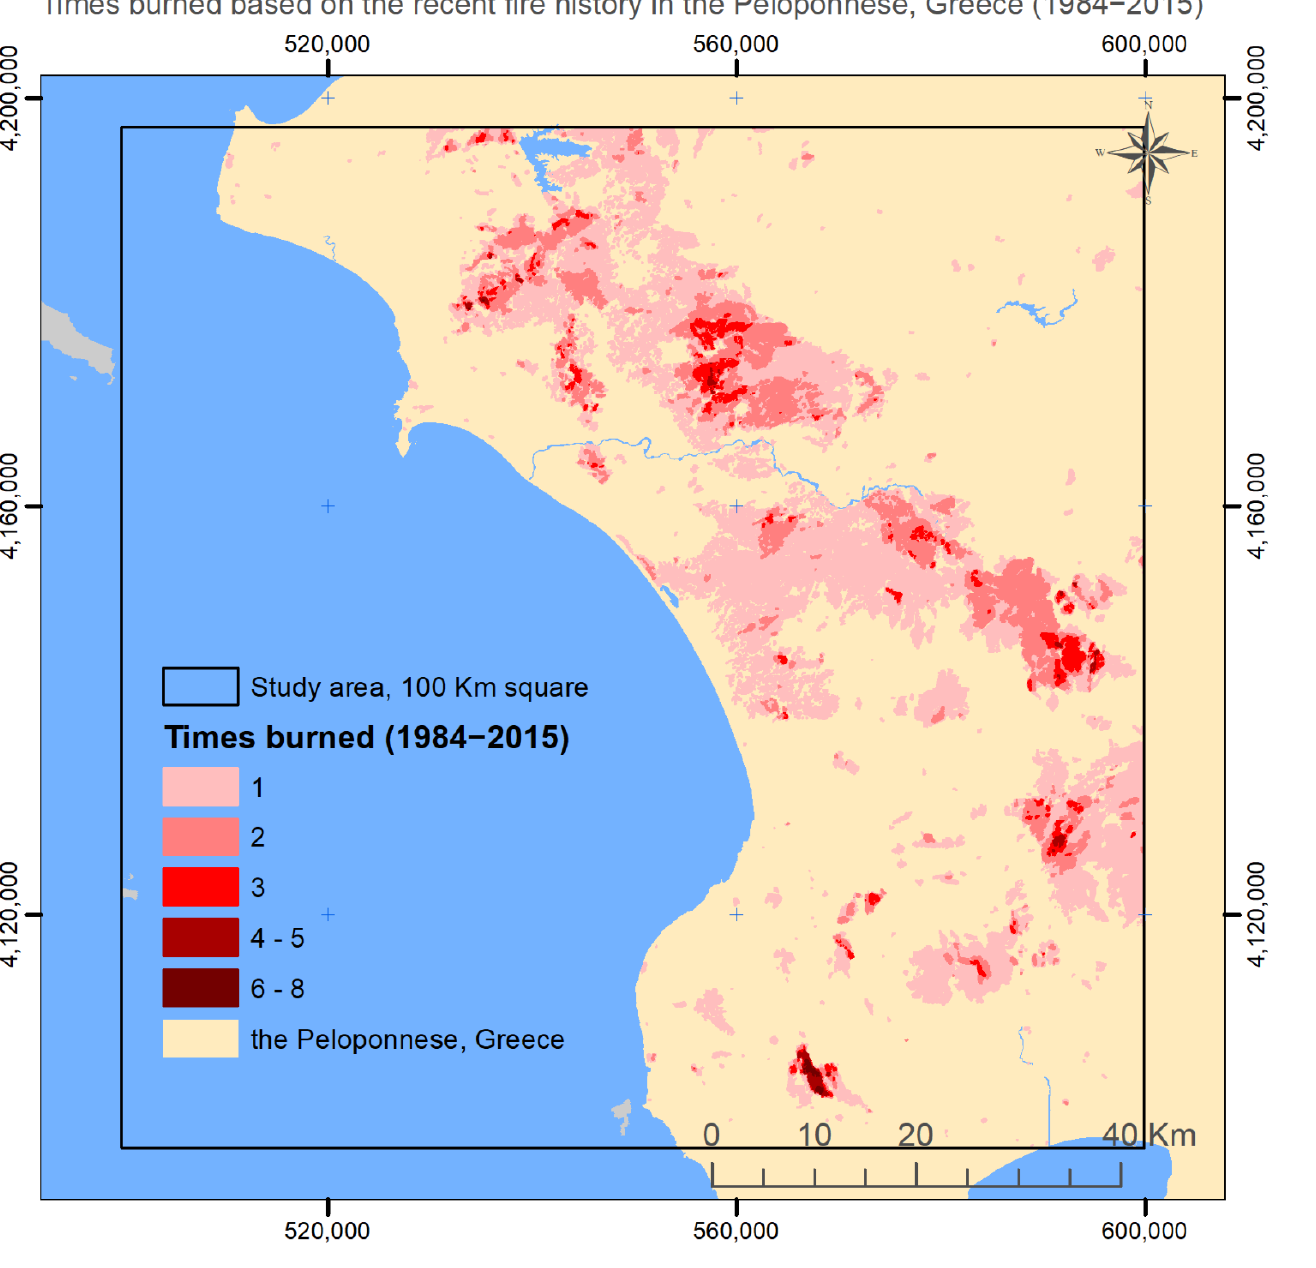
Figure 7. Times burned based on the spatially explicit reconstruction of the recent fire history using Landsat images.